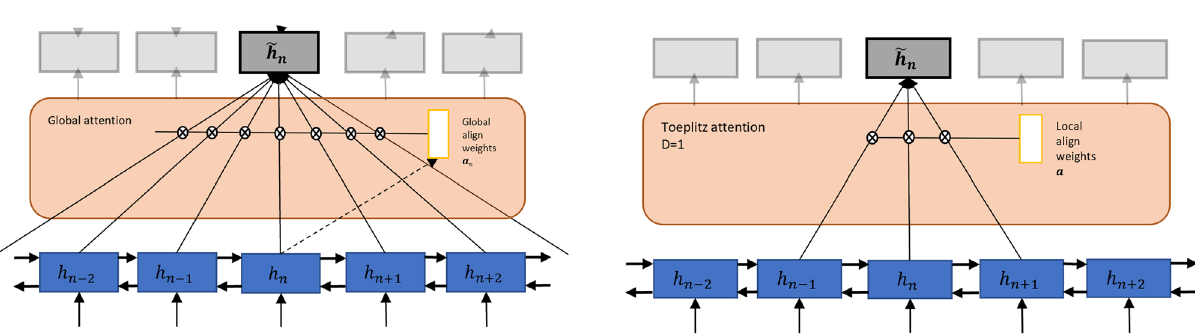
Figure 4. Attention mechanisms: (left) In the global attention model output decision for a particular slice is affected by all the slice in the stack, whereas (right) in the Toeplitz attention model the output is only affected by a local neighborhood of slices (e.g D = 1 in the exemplar). Note that this figure is intended to explain only the attention layers, the encoder and decoder structures can be seen in Fig.